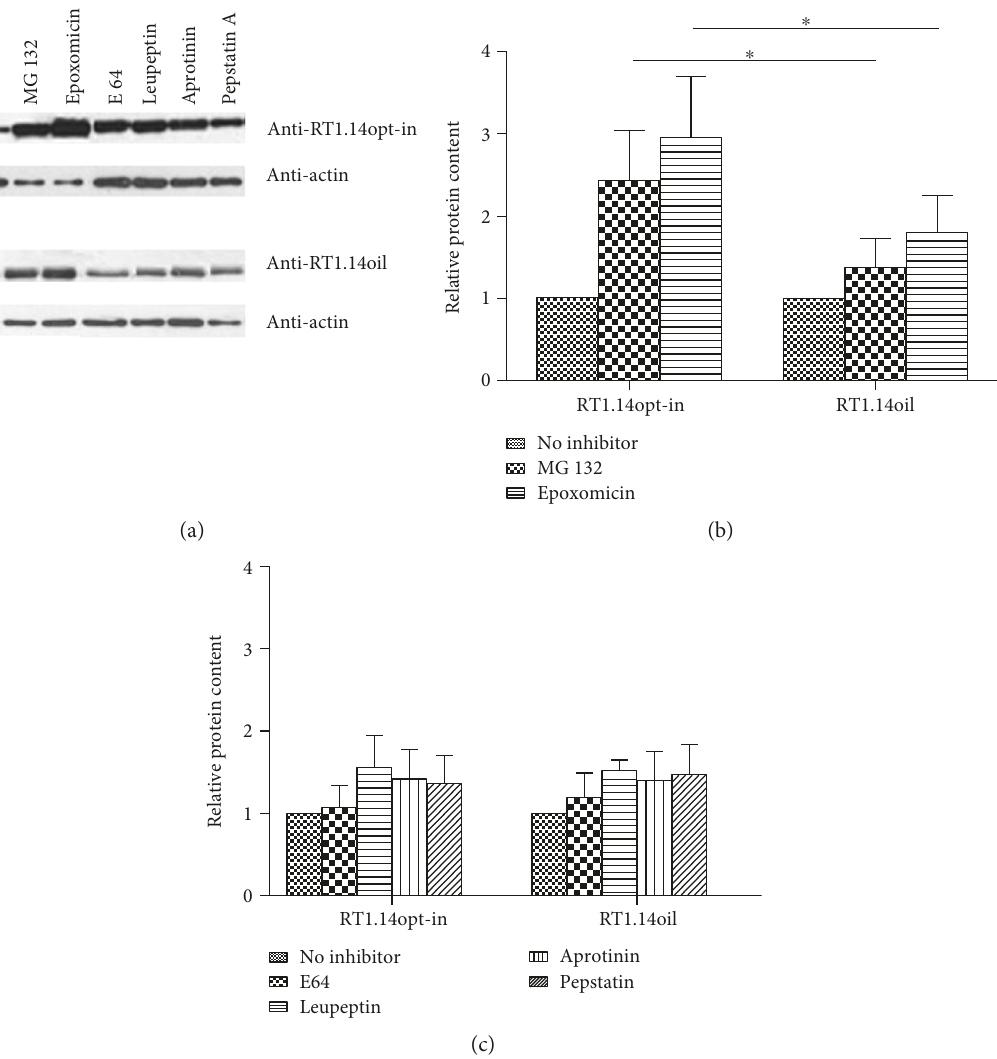
Figure 5: RT accumulation in HeLa cells treated with inhibitors of proteasomal and lysosomal proteolysis. Western blotting of HeLa cells transfected with pVaxRT1.14opt-in and pVaxRT1.14oil after 18-hour incubation with MG132 (5 μ М ), epoxomicin (0,1 μ М ), E64 (10 μ М